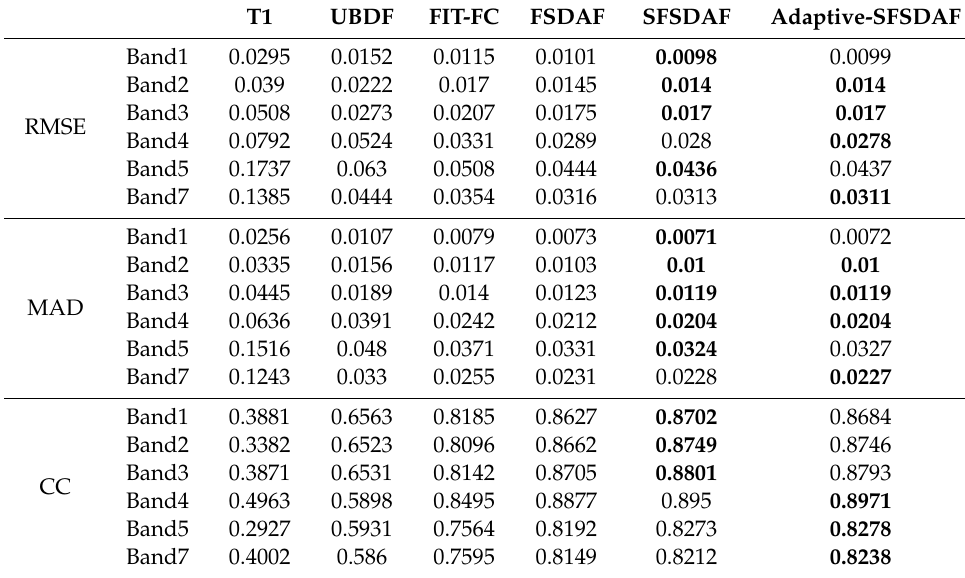
Table 2. Accuracy assessment of the five fusion methods at the Gwydir site in Figure 4. Bold data indicate the most accurate